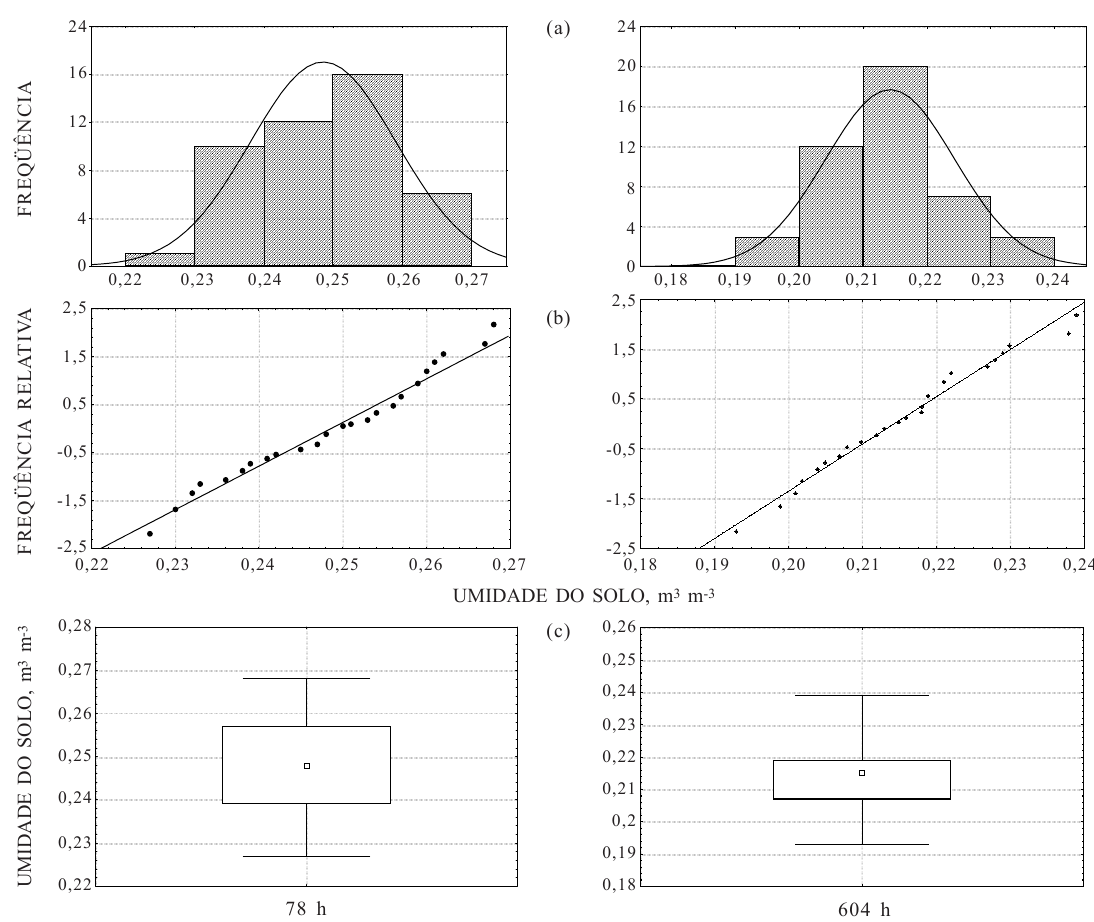
Figura 1. Histogramas de freqüência (a), retas de probabilidade de Henry (b) e gráfico “box-plot” (c) para umidade do solo ( θθθθθ ), na profundidade de 0,30 m nos tempos: inicial (78 h) e final (604 h), durante a drenagem em um experimento de perfil instantâneo.